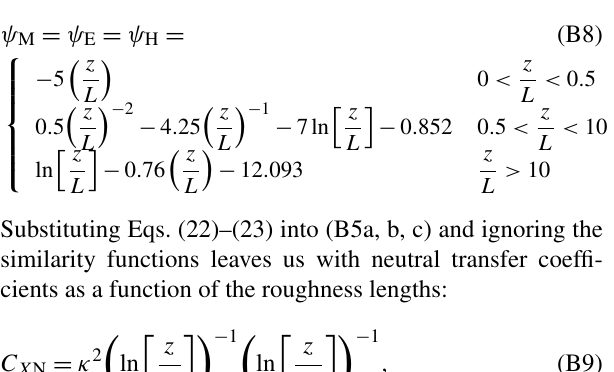
During stable stratification ( L > 0) they are assumed to take a form modified from Hicks